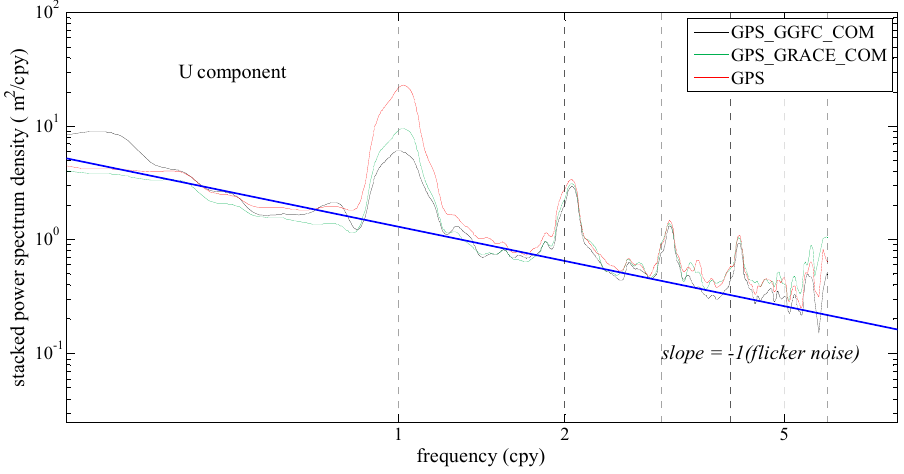
Figure 7. Stacked periodogram of the coordinate time series. The black vertical lines represent the 1.0 cycle per year (cpy) harmonics, respectively. The power-law behavior of flicker noise is denoted by the blue line with a slope of − 1.